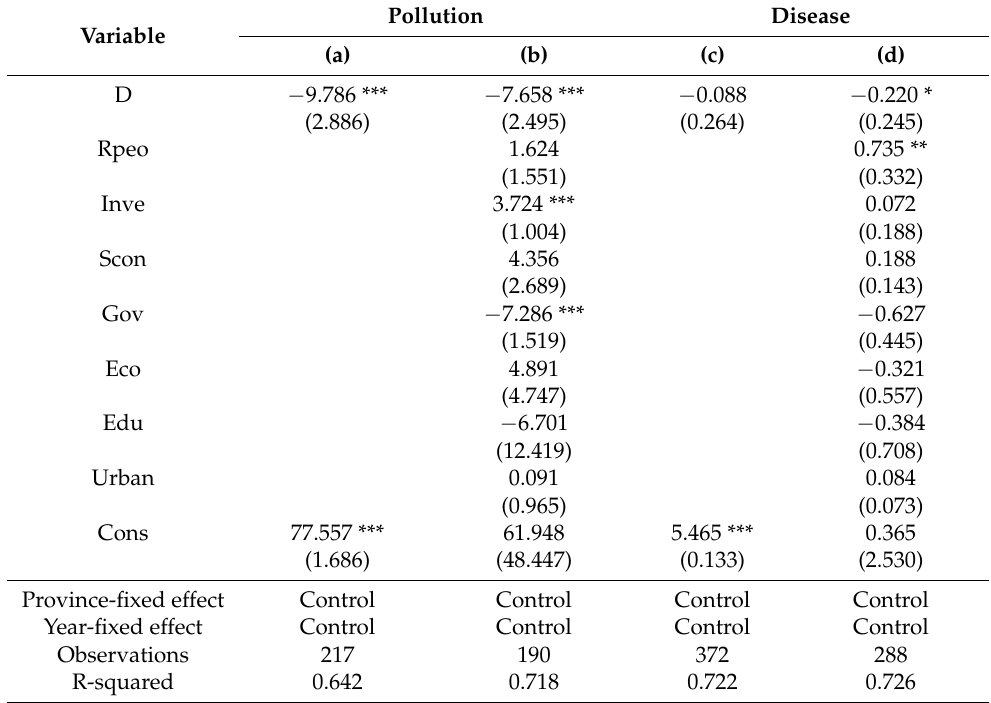
Table 2. Benchmark